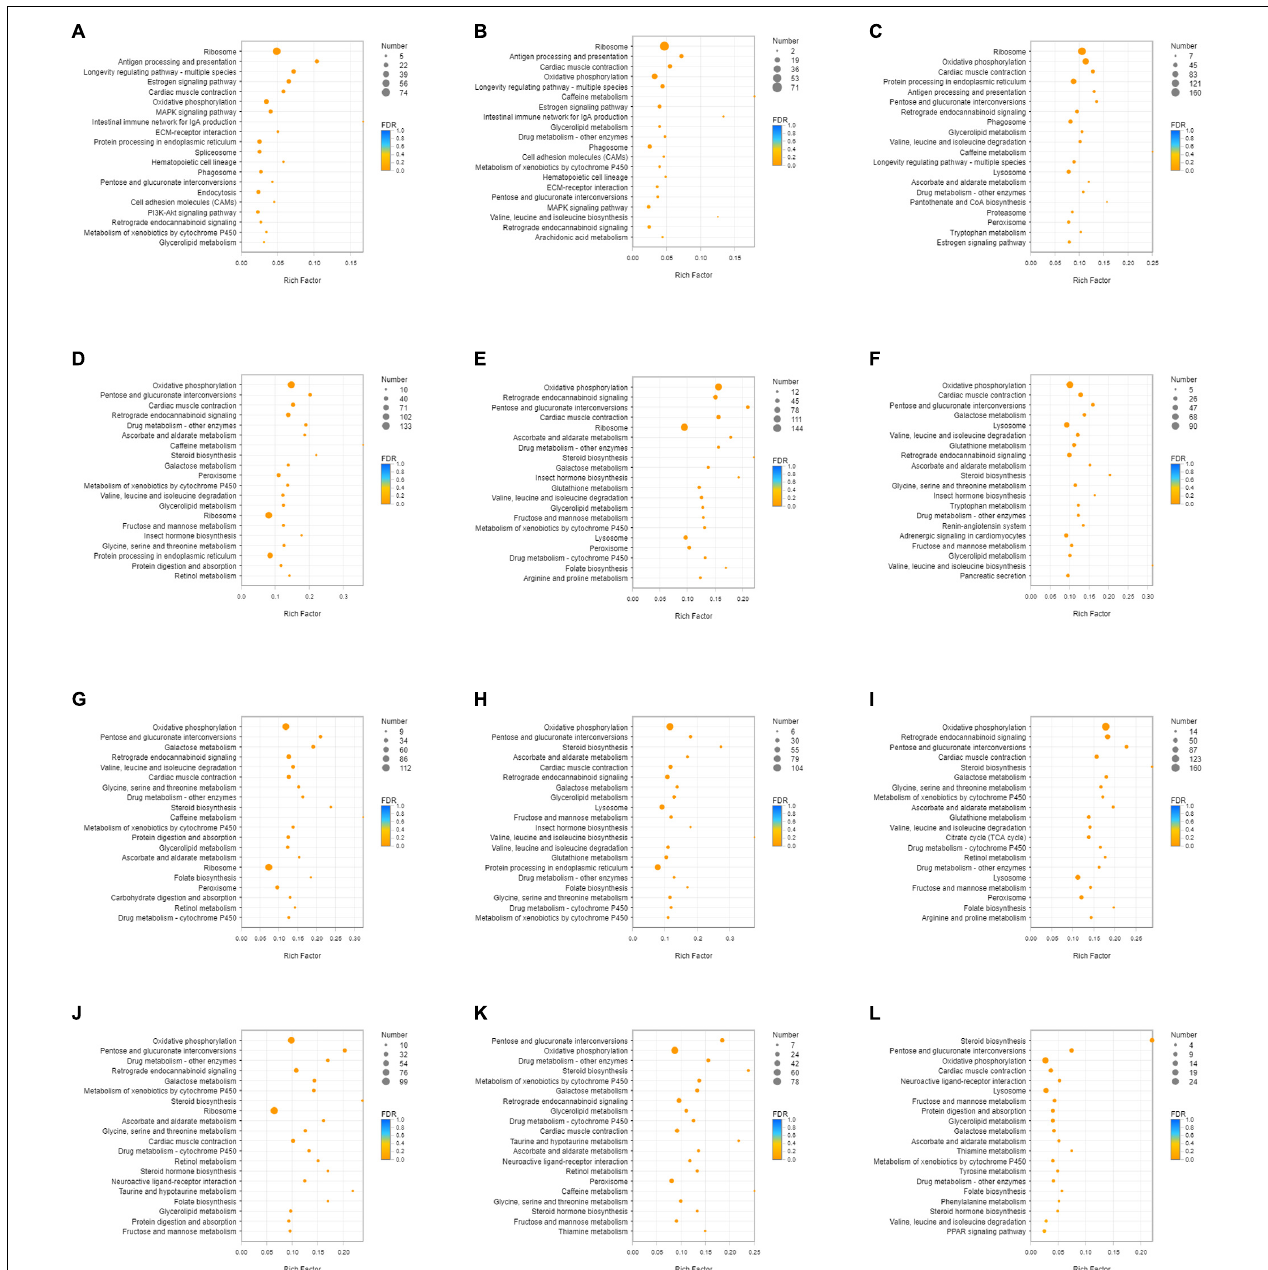
FIGURE 3 | KEGG enrichment analysis of down-regulated DEGs. (A) DEGs of SI_1 (B) DEGs of SI_2 (C) DEGs of SI_3 (D) DEGs of SI_4 (E) DEGs of SI_5 (F) DEGs of SI_6 (G) DEGs of SI_7 (H) DEGs of SI_8 (I) DEGs of SI_9 (J) DEGs of SI_10 (K) DEGs of SI_11 (L) DEGs of SI_12. The picture shows the top 20 differential metabolic pathways with the smallest P